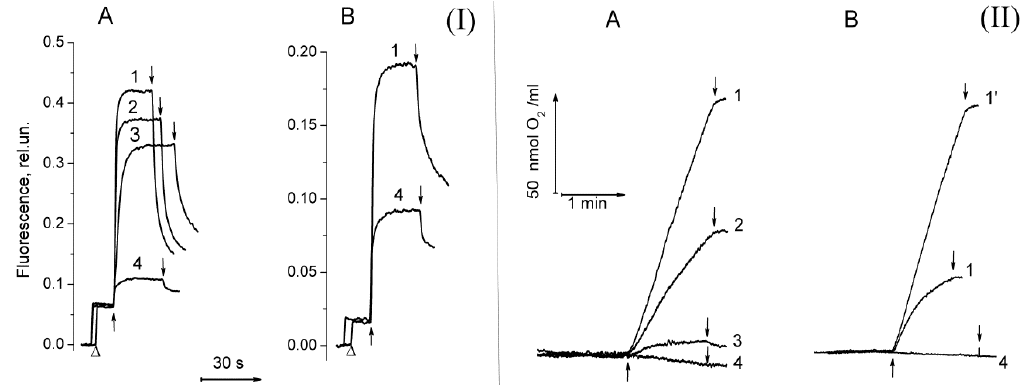
Figure 1. ( I ) Kinetics of photoinduced changes of chlorophyll fluorescence yield ( ∆ F) related to the photoreduction of the primary electron acceptor, Q A , in photosystem II (PSII) membranes fragments ( A ) and PSII core complexes ( B ) before (1) and after modification of the water-oxidizing complex caused by treatments with NaCl (2), CaCl 2 (3), and NH 2 OH (4). The measurements of ∆ F were done in a medium containing 50 mM MES–NaOH (pH 6.5), 35 mM NaCl and 0.4 M sucrose at a Chl concentration of 10 µ g / mL. ∆ , switching of the measuring light; ↑ and ↓ , actinic light on and o ff , respectively. ( II ) Kinetics of oxygen evolution in PSII membranes ( A ) and PSII core complexes ( B ) before (1) and after modification of the water-oxidizing complex caused by treatments with NaCl (2), CaCl 2 (3), and NH 2 OH (4). The measurements were made in the medium containing 50 mM MES–NaOH (pH 6.5), 35 mM NaCl, 0.4 M sucrose at a Chl concentration of 10 µ g / mL for the PSII membranes and at 5 µ g / mL for the PSII core complexes in the presence of 1 mM K 3 [Fe(CN) 6 ] and 100 µ M DCBQ. (1 (cid:48) )—oxygen evolution in the PSII core complexes was done in the presence of 5 mM CaCl 2 . ↑ and ↓ – light ( λ > 650 nm, 1500 µ mol photon s − 1 m − 2 ) on and o ff , respectively.